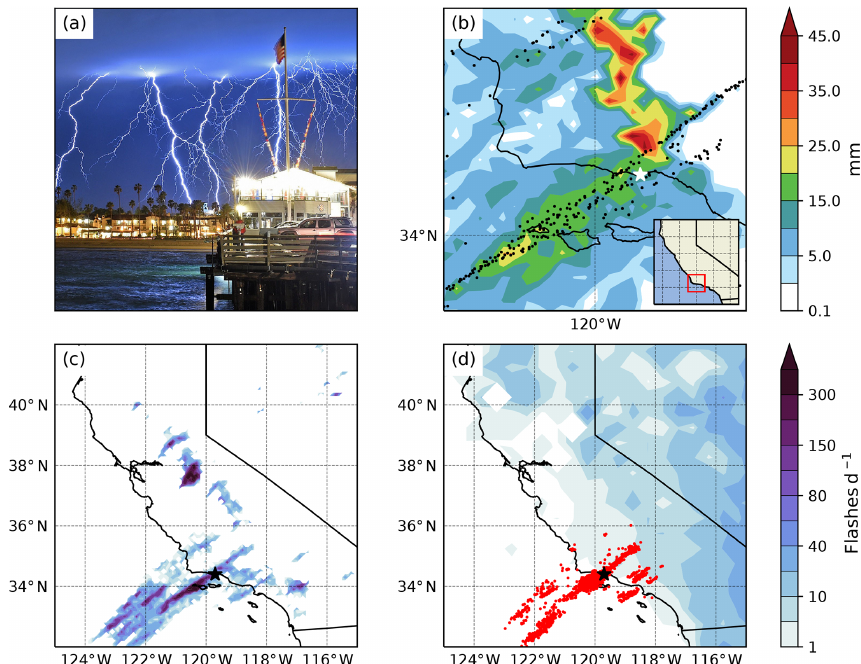
Figure 1. (a) Photo of lightning at the Santa Barbara Harbor in Santa Barbara, CA, taken by Mike Eliason from the Santa Barbara County Fire Department during the storm on 6 March 2019 04:00UTC. (b) NOAA NEXRAD L3 precipitation accumulation (shaded; mm) and locations of NOAA NEXRAD L3 hail signatures (black points) between 5 March 2019 12:00UTC and 6 March 2019 23:59UTC. The location of Santa Barbara is indicated by the white star. (c) ENGLN lightning strike frequency (shaded; flashesd − 1 ) on 6 March 2019. The location of Santa Barbara is indicated by the black star. (d) Climatological annual mean lightning density (shaded; flashesd − 1 ) between 1995 and 2014 using TRMM LIS-OTD lightning climatology and lightning strike locations (red points) between 04:00 and 05:00UTC on 6 March 2019 based on ENGLN. The location of Santa Barbara is indicated by the black